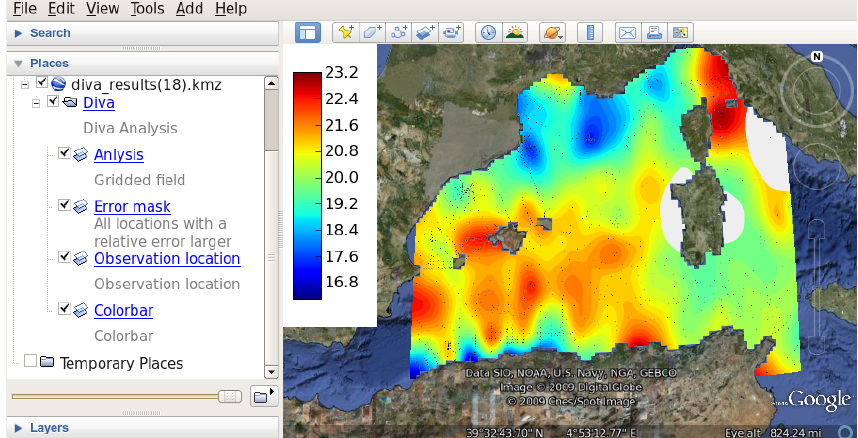
Fig. 8. Analyzed surface temperature of the western Mediterranean Sea in Google